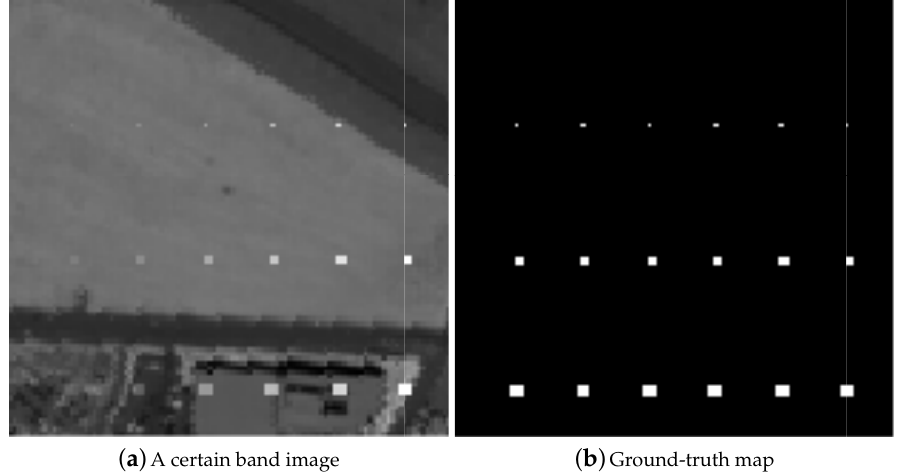
Figure 3. Simulated